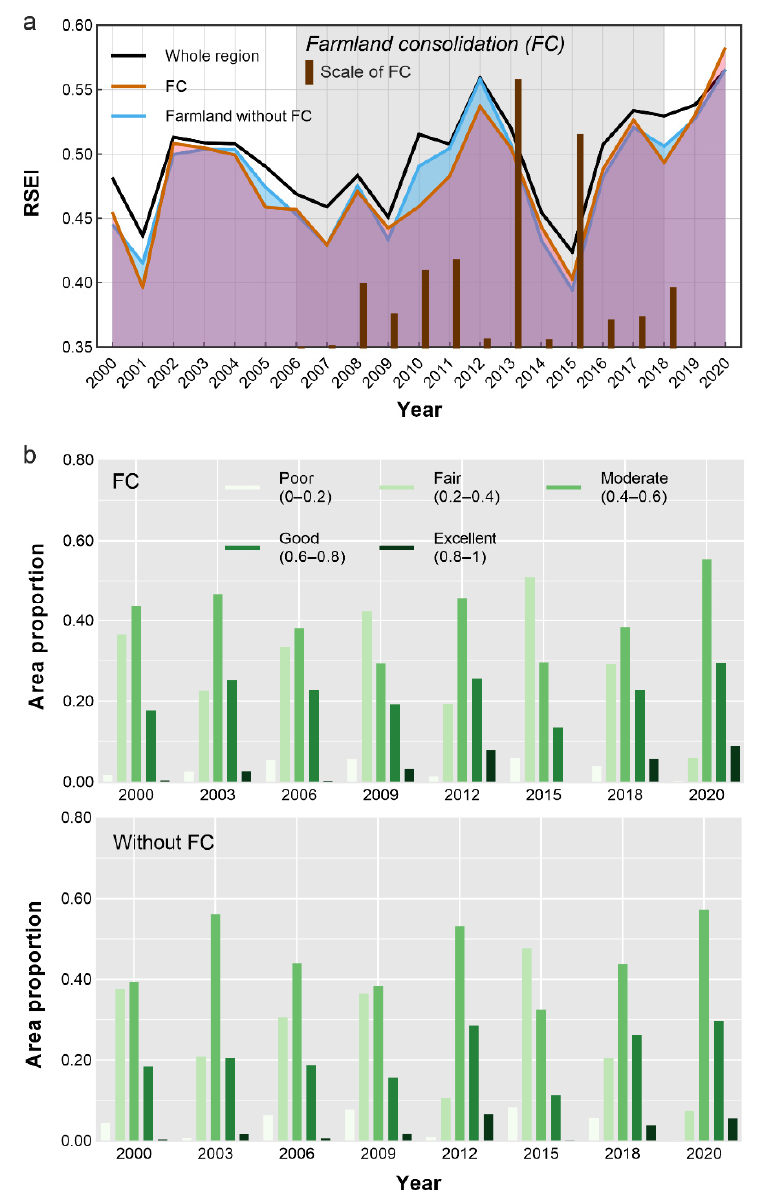
Figure 4. The changes in the average RSEI values for the whole study region, FC areas, and farmland without FC in each year. The coverage years of the FC phases are in gray ( a ); area distribution of EEQ levels in FC areas and in the farmland without FC in the selected years, from 2000 to 2020 ( b ). For the convenience of presentation, we chose to display one years from each three-year